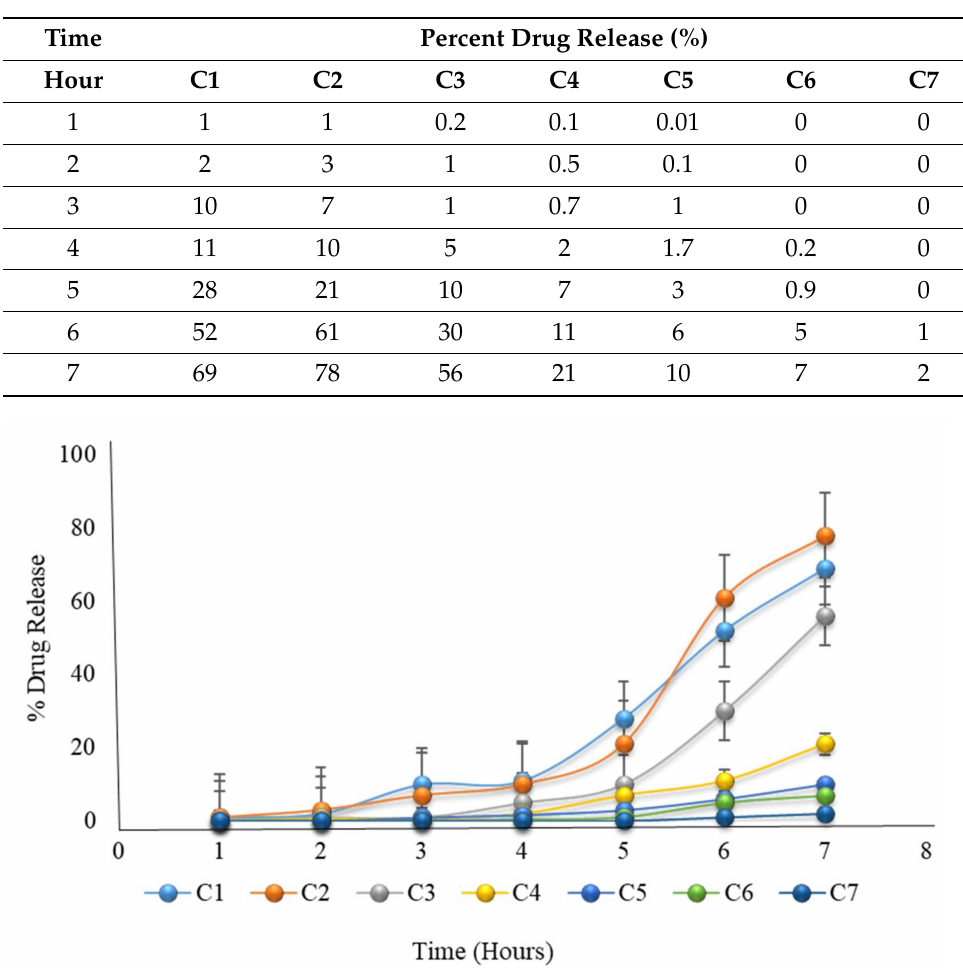
Figure 4. The in vitro dissolution of formulations C1 to C7 (the first 2 h in an acid medium of pH 1.2, and then in a phosphate buffer medium of pH 6.8) showing that all formulations failed to release the drug even after 6